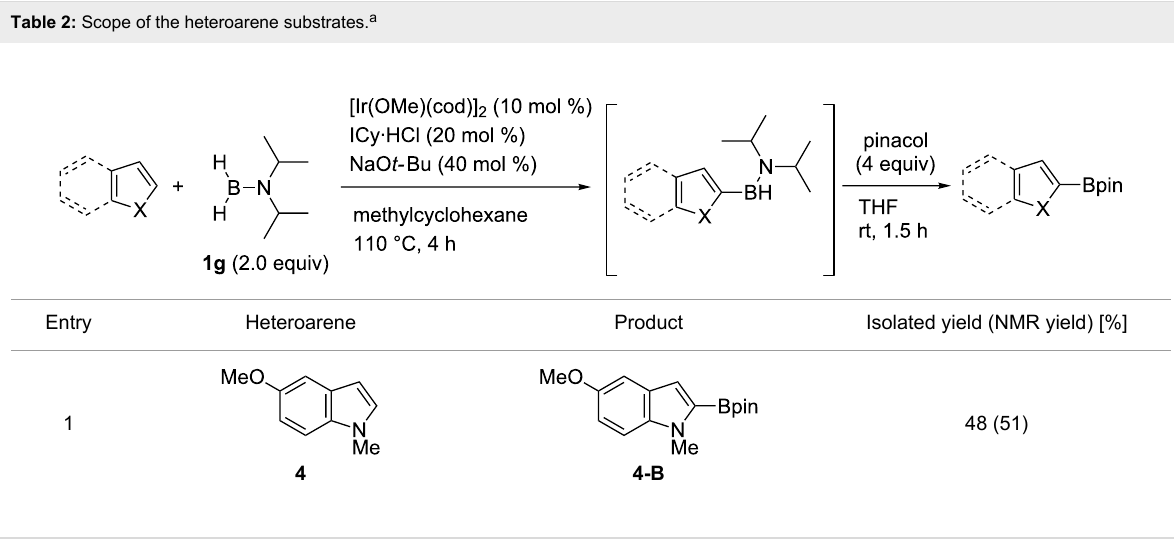
Table 2: Scope of the heteroarene substrates.